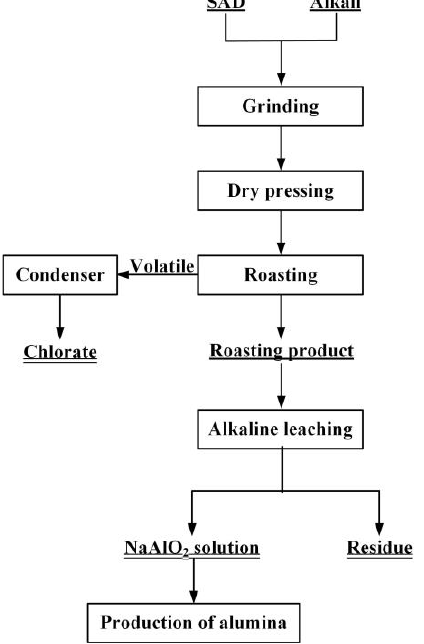
Figure 1. Flowchart of the preparation of alumina using SAD as the raw material.